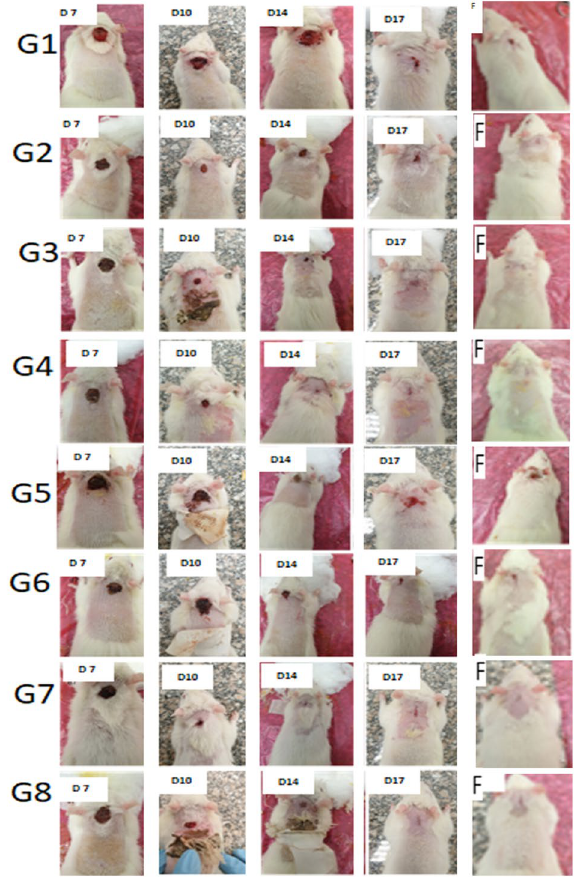
Figure 4. Photoimages for wound treatment to the different groups at days 7, 10, 14, 17 and